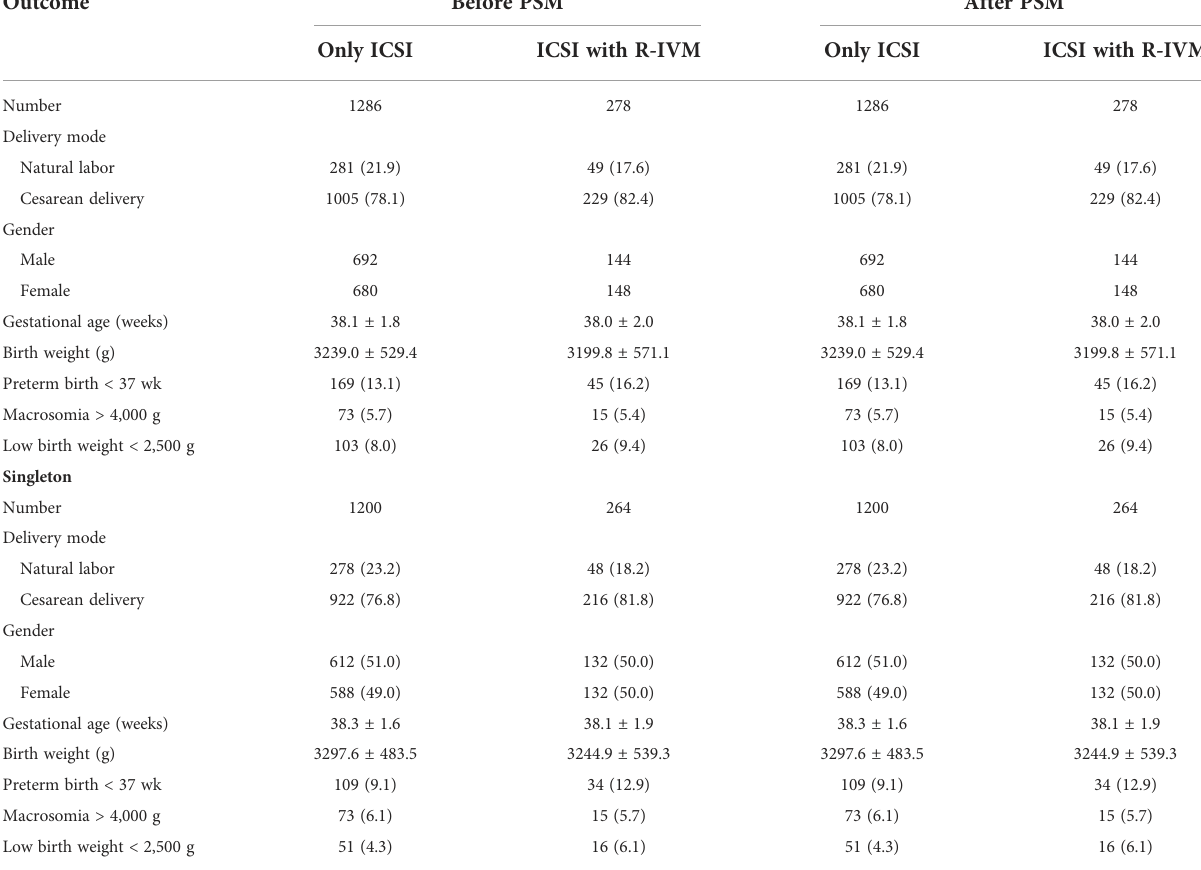
TABLE 4 Neonatal outcomes of women undergoing only ICSI and women undergoing ICSI with R-IVM.